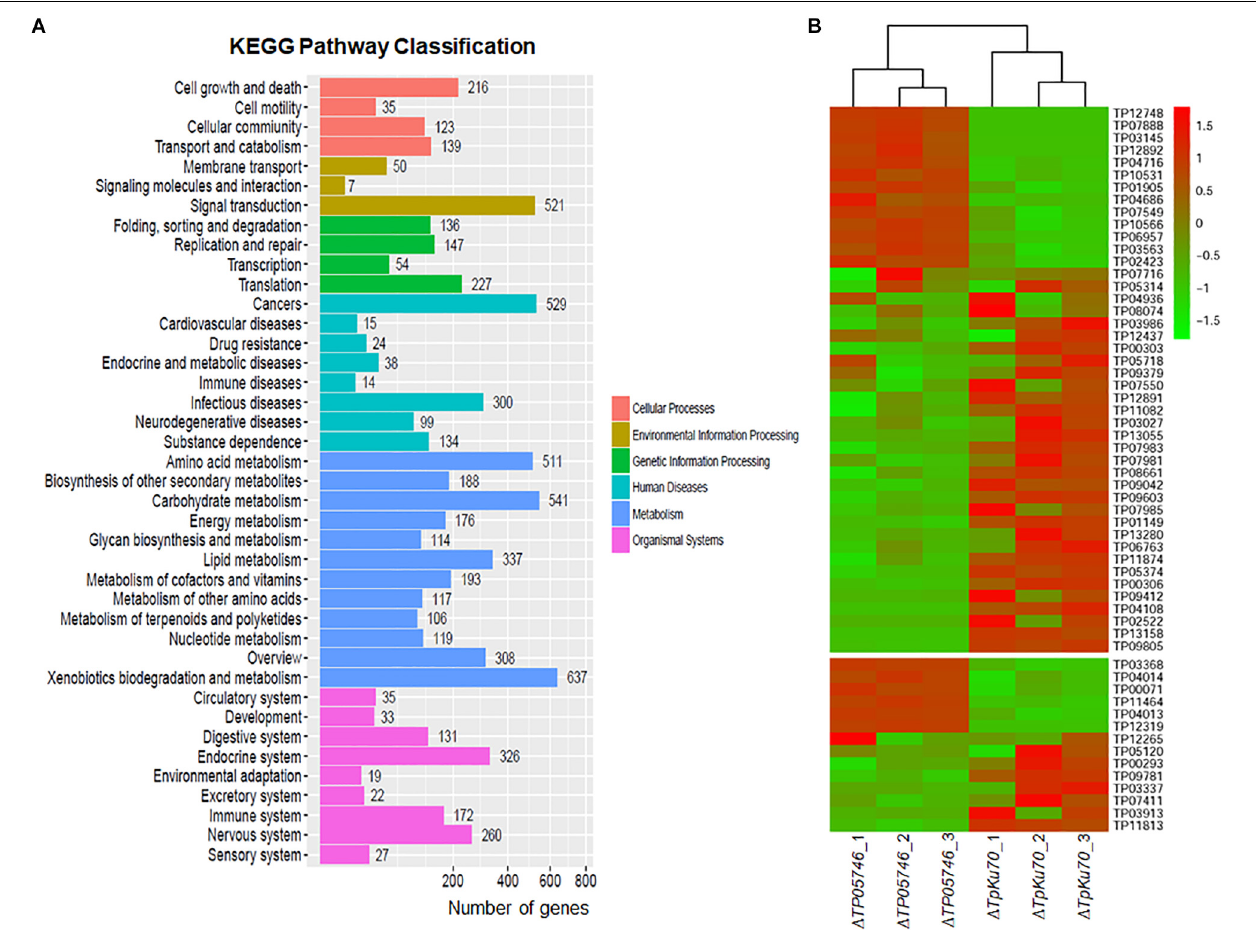
FIGURE 6 | Transcriptomic analysis of T. pinophilus mutant (cid:49) TP05746 and the parental strain (cid:49) TpKu70 cultured in SLM containing SCS as the sole carbon source for 12 h. (A) KEGG pathway classification annotation of 4429 DEGs in the (cid:49) TP05746 [a | log2(fold change)| ≥ 1 and a p -value ≤ 0.05 as thresholds]. (B) Plant cell-wall-degrading enzymes and amylase genes regulated by TP05746 . SLM, standard liquid medium; SCS, soluble corn starch; KEGG, kyoto encyclopedia of genes and genomes; DEGs: differently expressed